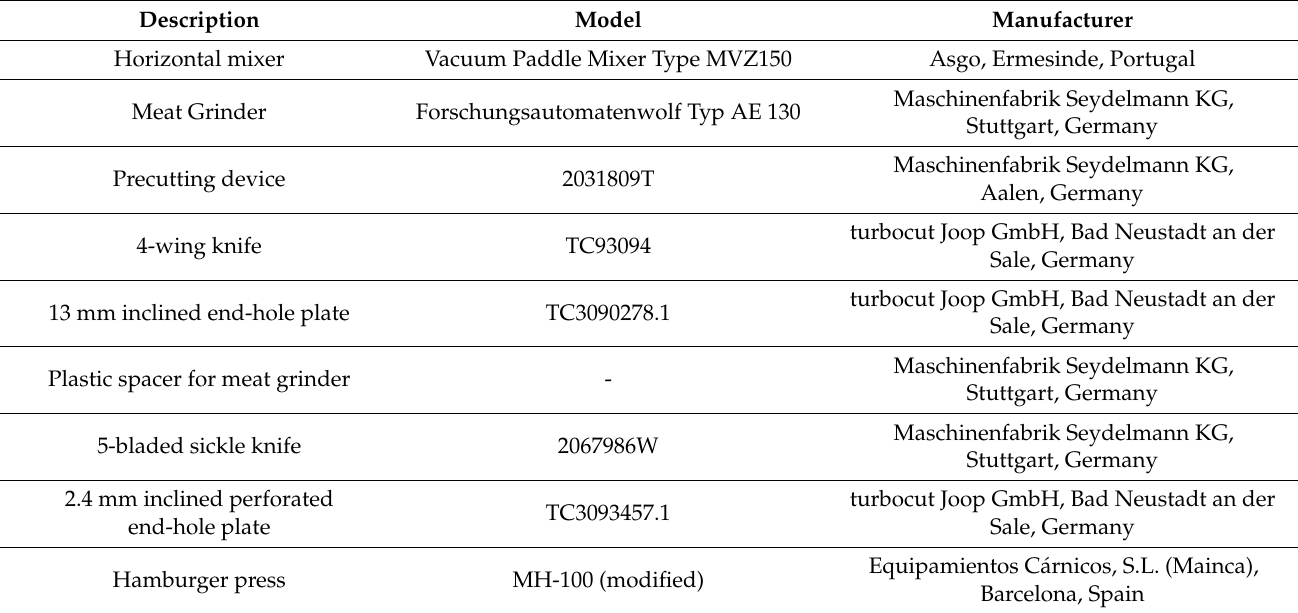
Table 1. Details on equipment used for hamburger